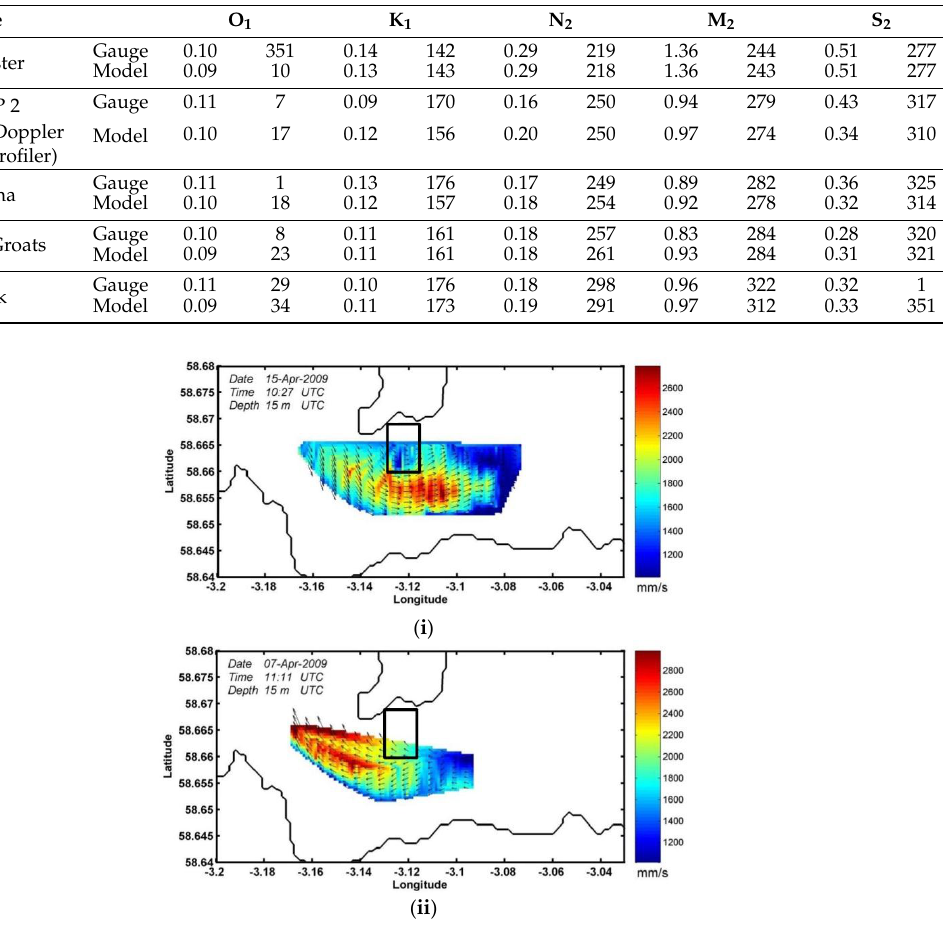
Table 1. Modelled and observed amplitude (m) and phase (°) of the tidal height for the five principal tidal constituents at five locations around the Pentland Firth (see Figure 1).